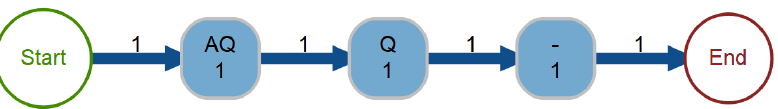
Figure 3. Graphical representation of the sequence of backpacks for the student with s = 23, shown as an example in Table 2, according to the BPPM